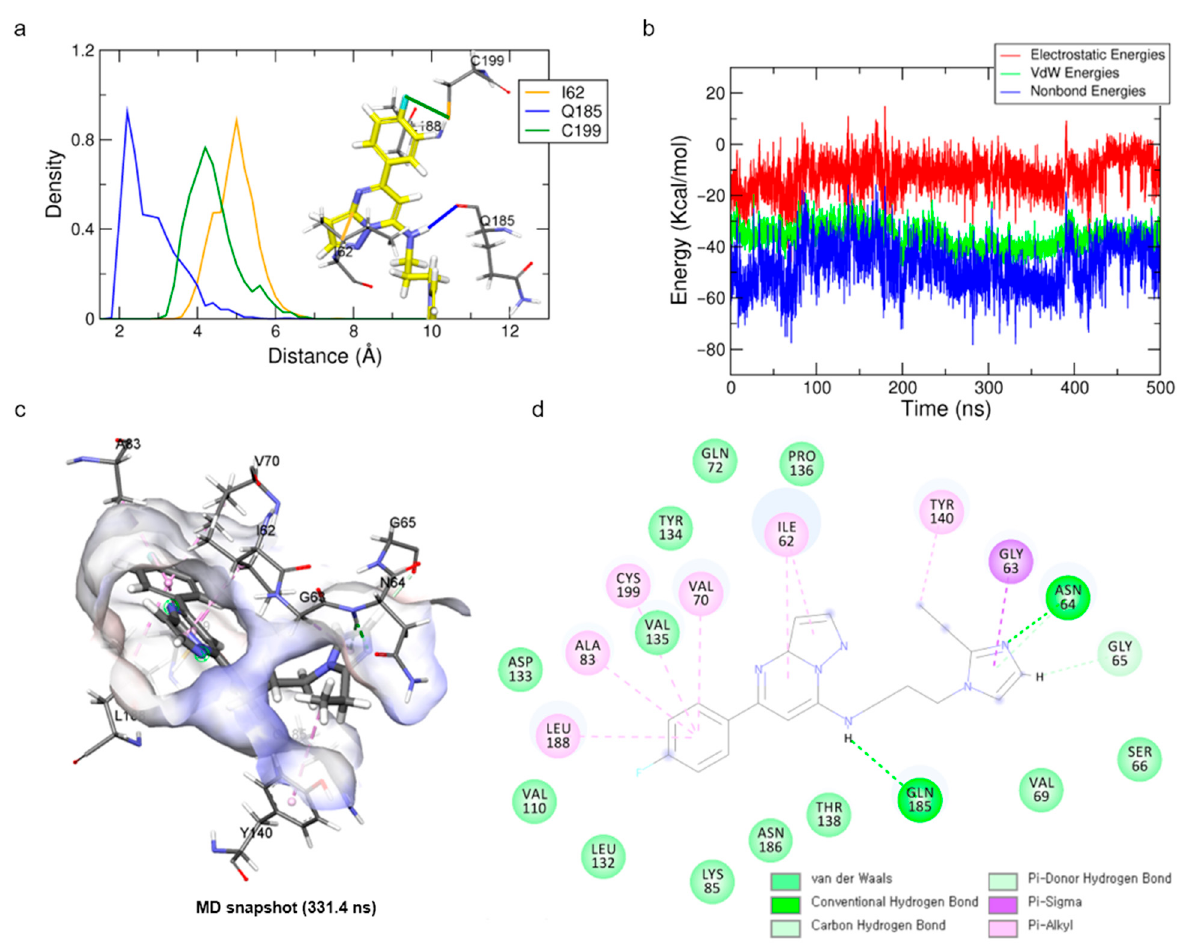
Figure 4. Binding mode results obtained from MD simulation for hit compound cpd1. ( a ) Distance distribution of cpd1 with three key residues during the last 200 ns. The orange, blue, and green lines represent the distance of ligand:C1, ligand:H6, and ligand:F towards I62:CB, Q185:O, and C199:SG, respectively. The cpd1 is shown as a yellow stick model. ( b ) Protein–ligand non-bond energy for cpd1 bound system during the simulation time. ( c ) Binding mode of cpd1 with GSK3 β protein. ( d ) A 2D diagram for the binding mode.